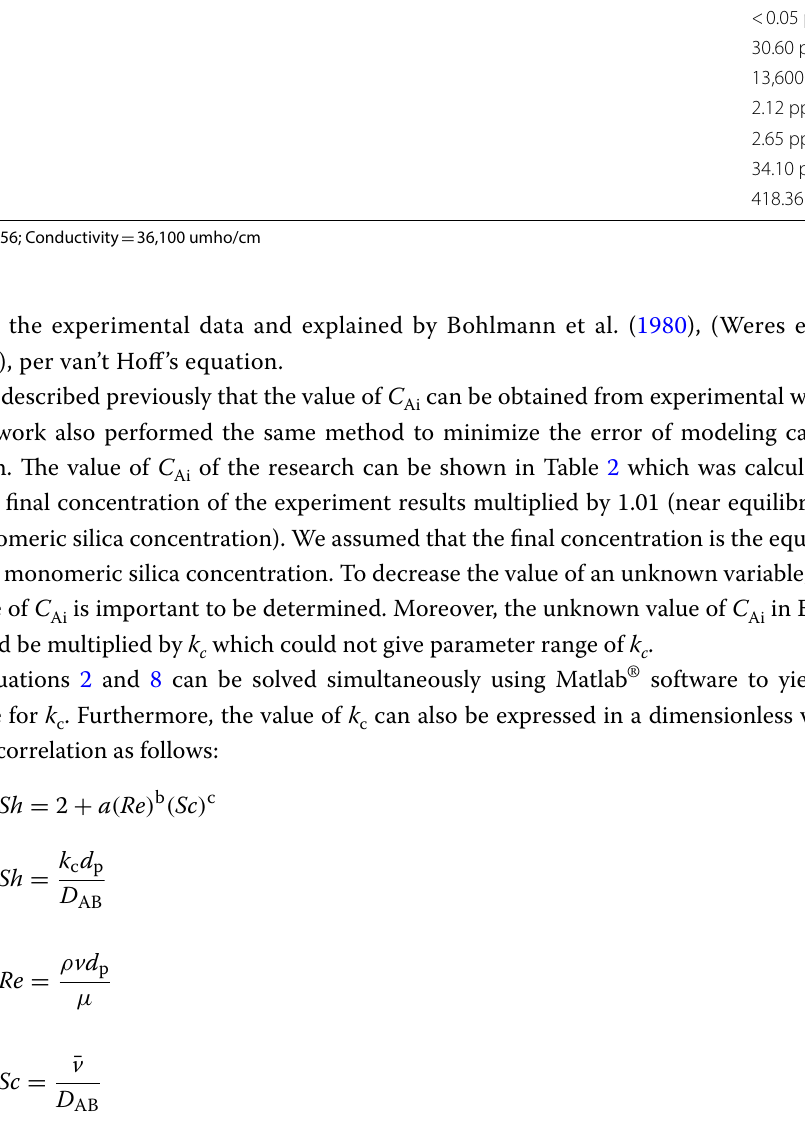
Table 1 Chemical composition and parameters of geothermal brine from the geothermal well (Unit 3A–3B) at Dieng geothermal power plant